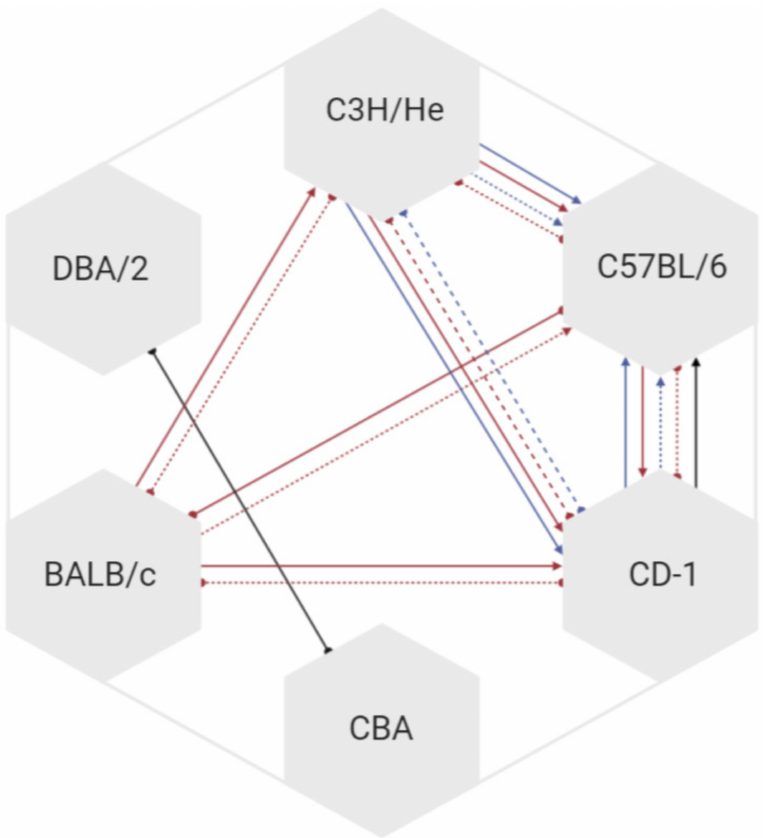
Figure 6. Network map comparing MGS scores between strains. Each line represents a study effect. The direction of the arrow represents that the strain at the arrowhead responded with a lower MGS score. Red lines indicate a comparison between female mice, blue lines indicate comparison between male mice, and black lines indicate comparisons where sex was not separated. A solid line indicates that a live score was used, a dashed line indicates that a retrospective score was